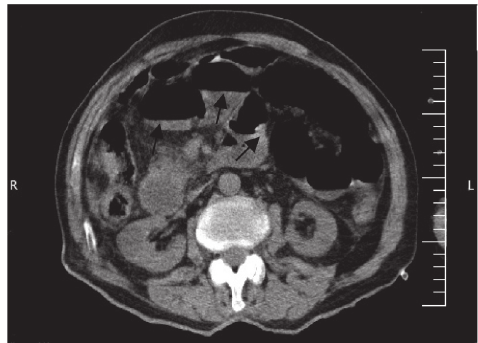
Figure 4: Male patient’s abdominal CT (arrows: dilated small bowel